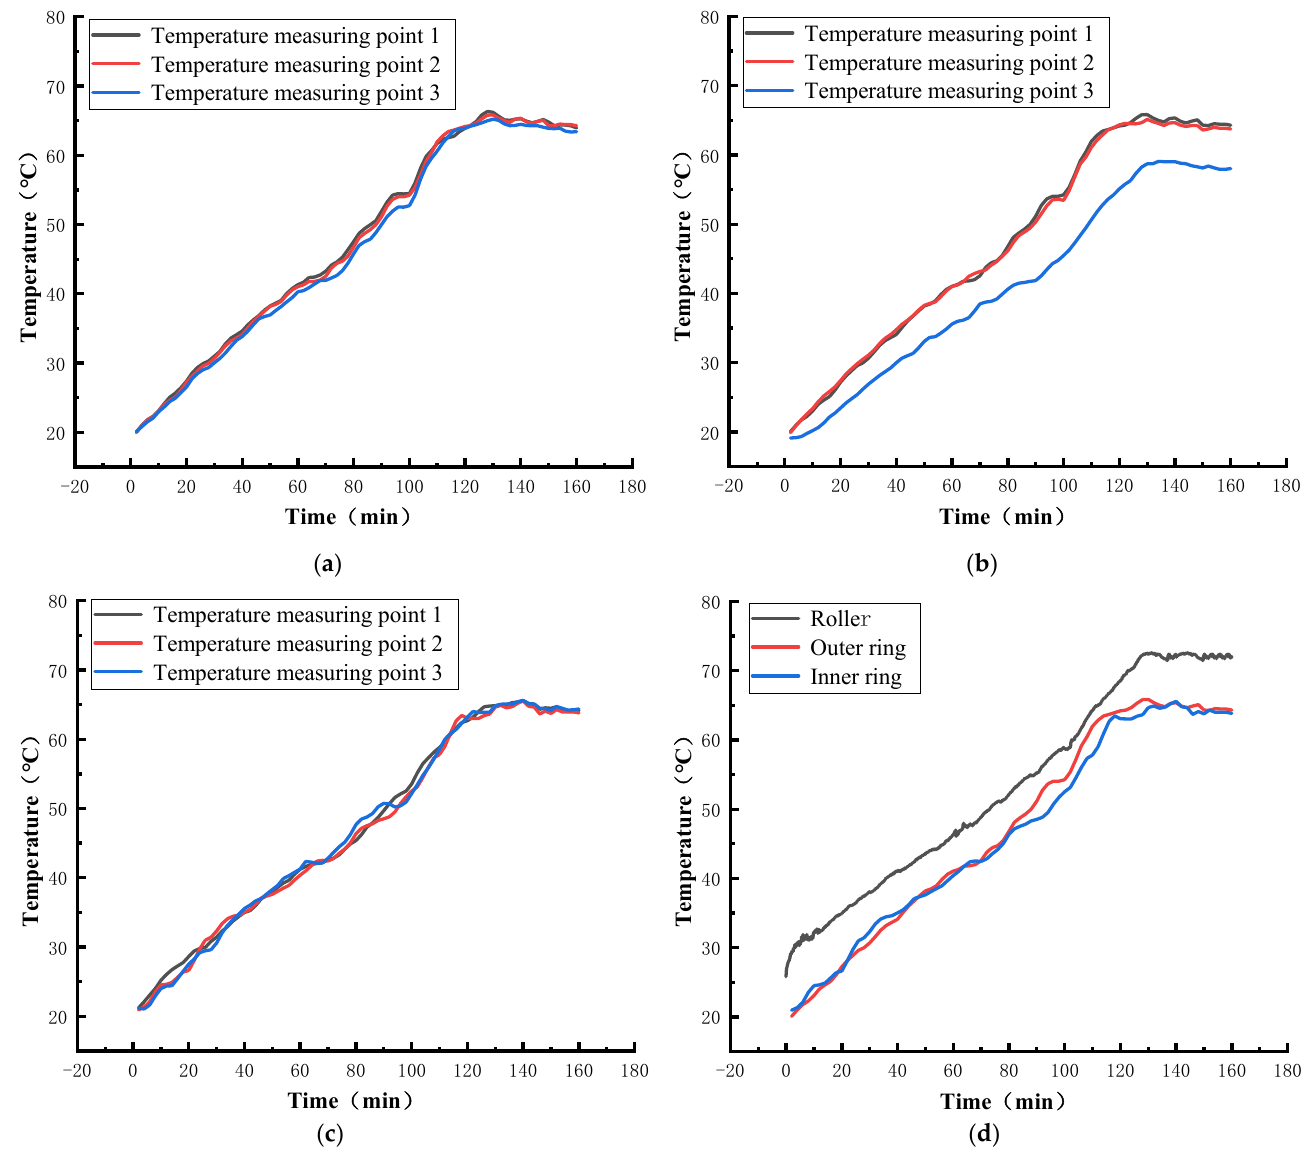
Figure 16. Temperature rise curve of railway bearing 353130B: ( a ) the circumferential direction of outer ring; ( b ) outer ring axial; ( c ) the circumferential direction of inner ring; ( d ) radial bearing.